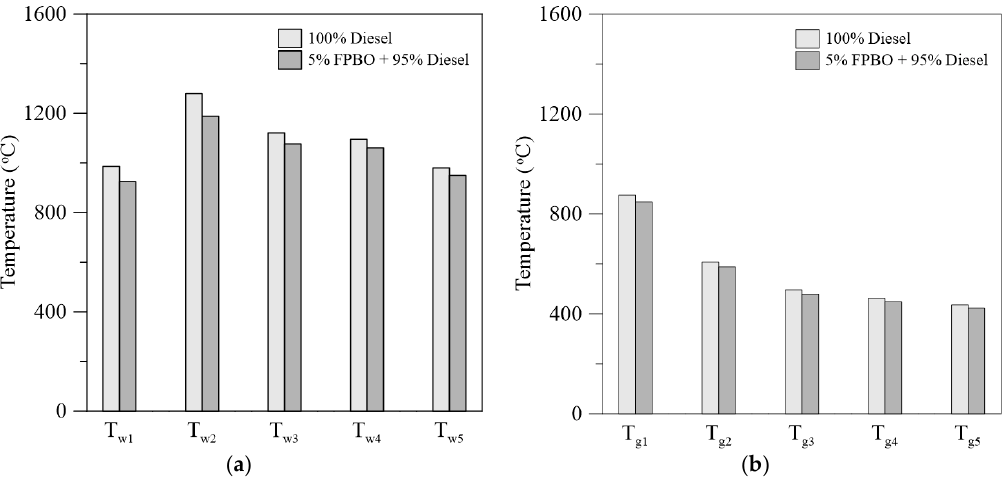
Figure 6. Comparison of average temperatures for burning diesel alone and the blend of 5% FPBO + 95% diesel: ( a ) the wall temperatures ( T w1 – T w5 ) in the radiative section; and ( b ) gas temperatures ( T g1 – T g5 ) in the flue gas section.